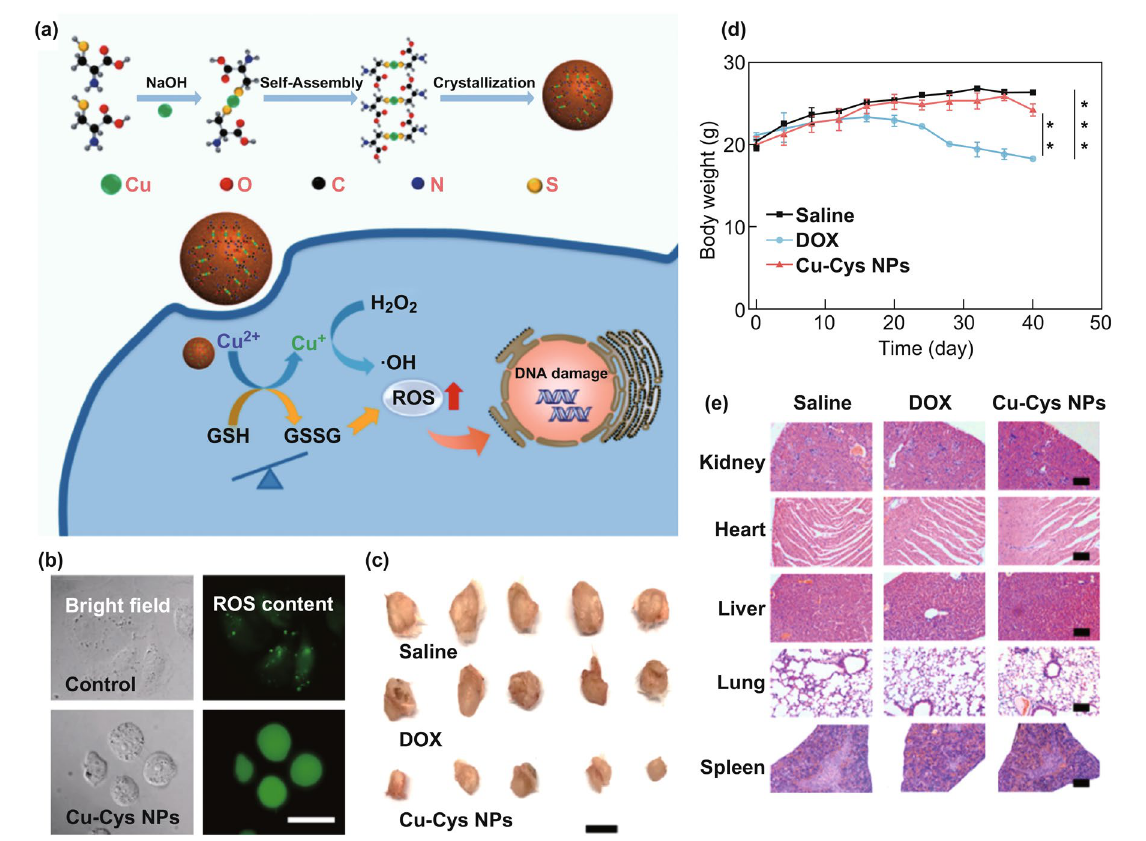
Fig. 7 a Schematic diagram of the synthesis and action mechanism of Cu-Cys NPs. b Detection of ROS in ADSCs and MCF-7R cells before and after Cu-Cys NPs treatment. c Photographs of tumors collected from the mice. d Changes in body weight of mice during treatment. e